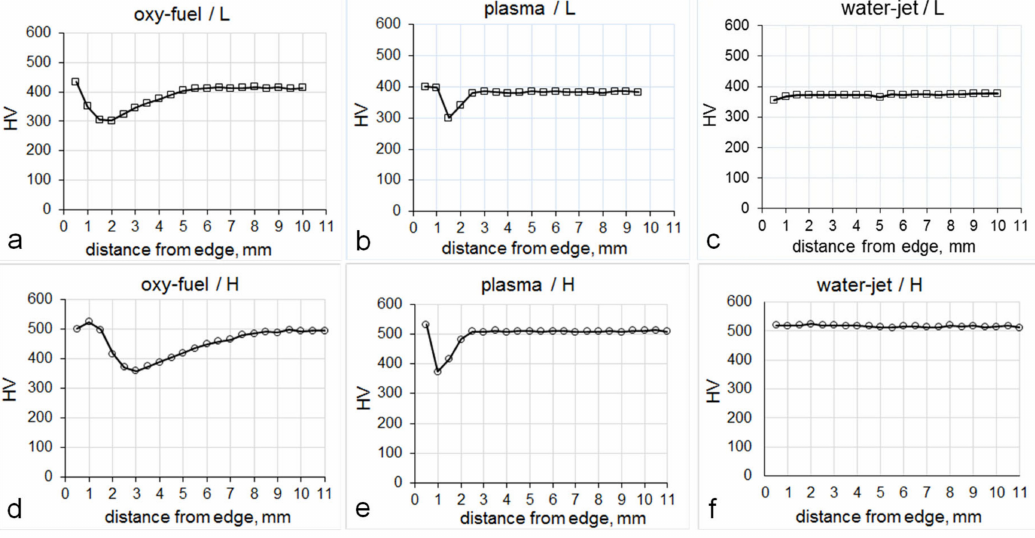
Figure 2. Hardness profiles at the plate mid-thickness position for ( a – c ) Steel L and ( d – f ) Steel H cut with ( a , d ) oxy-fuel, ( b , e ) plasma and ( c , f ) water-jet; each point on the hardness profiles is the mean value of 5 indentations made through plate